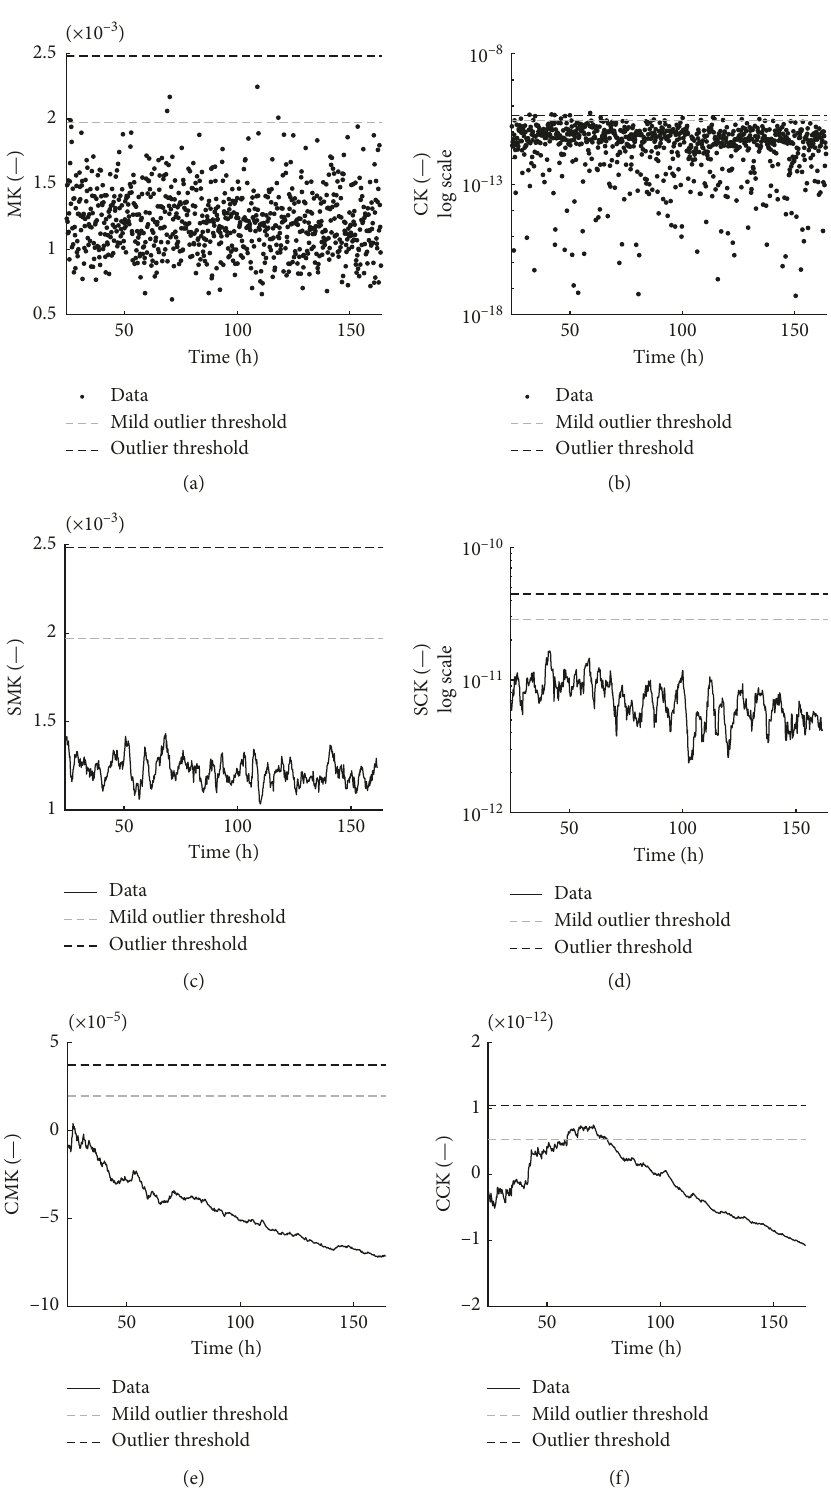
Figure 9: Application of the proposed method considering the inner race fault frequency starting from (a, c, e) MOMEDA and (b, d, f)